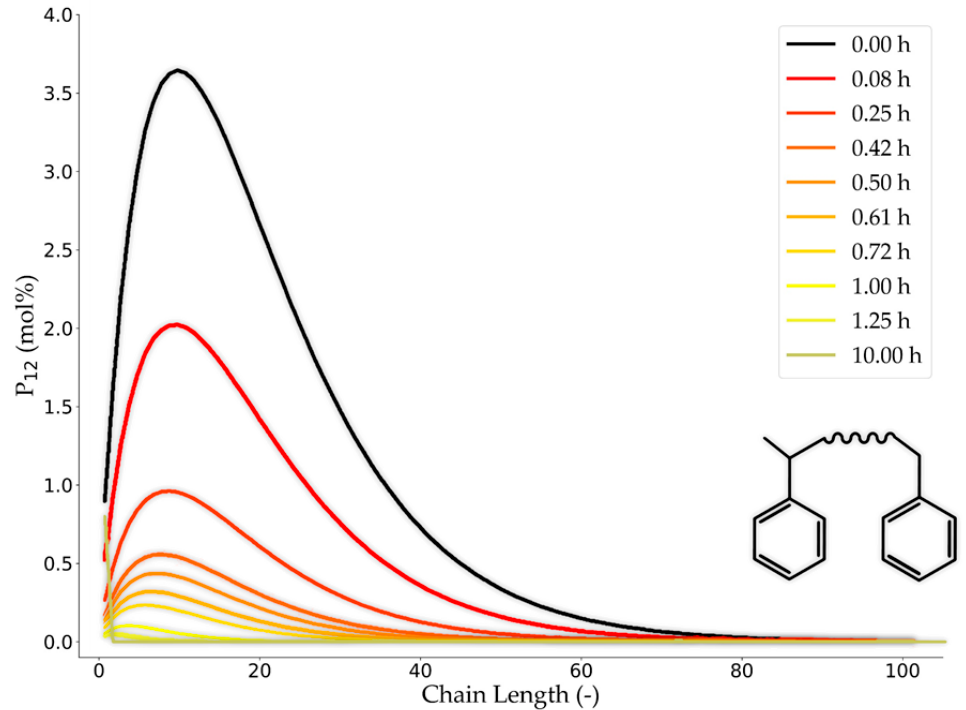
Figure 7. The initial, and transformation of the, chain-length distribution (molar mass distribution) of a type of Poly(styrene peroxide) (P 12 ) during the thermal degradation, predicted by a tree-based kinetic Monte Carlo coupled to an artificial intelligence tool. Reprinted (adapted) with permission from [94]. Copyright 2021 American Chemical Society.